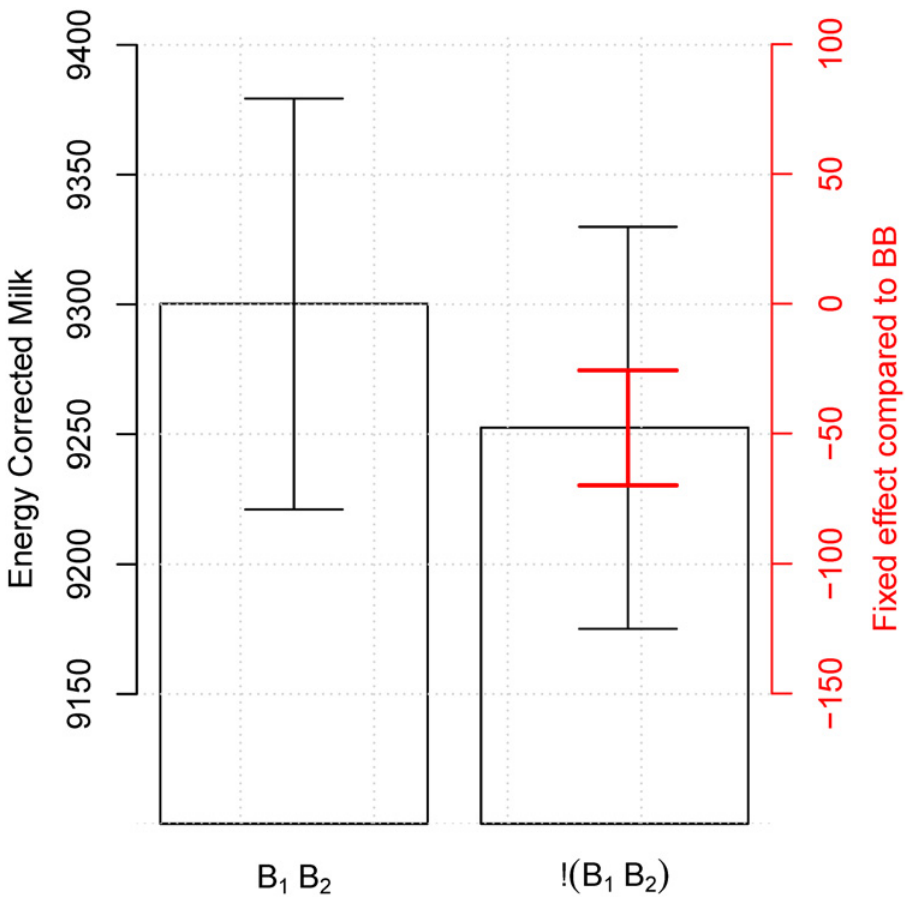
Fig 3. Influence of calf sex on milk production in the second lactation period. When using the best model (Eq 2) including yearly, seasonal, calving, and herd effects there is a significant difference 47.74 ECM ( sd = 11.25) between having two bull calves and any other combination of offspring (red CI). When including the variance of the reference level the difference is masked (black CI). The numerical results are available